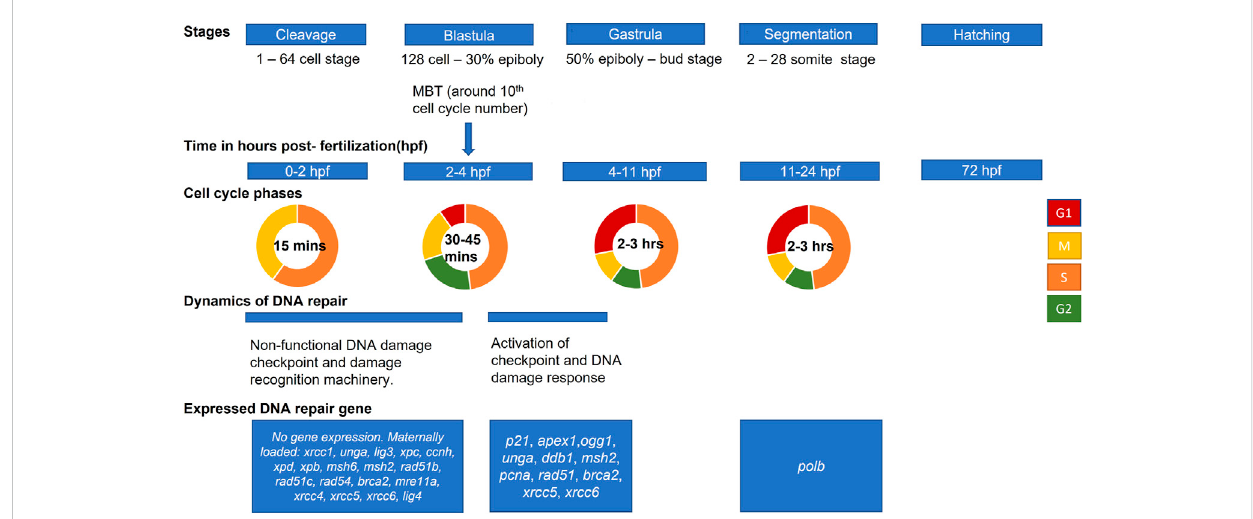
FIGURE 2 Scheme of zebra fi sh embryo development and main events in activation of DNA damage response. Developmental stages and approximate hours post-fertilization (at 28.5 ° C) for each stage are shown from cleavage ( fi rst cell divisions) to hatching (based on Kimmel et al., 1995). The mid-blastula transition (MBT)markschangesincellcycleandactivation ofcheckpoints. Activationofzygotictranscriptionatthisstageisassociatedwithexpressionof some DNA repair